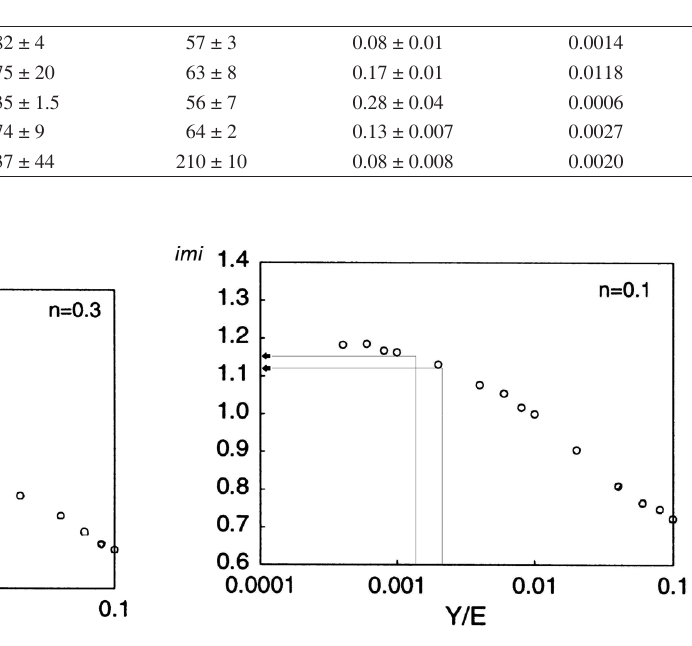
Table 3. Yield strength ( Y ), elastic modulus ( E ) and strain-hardening exponent ( n ) for the different materials. Material and temper (where applicable)